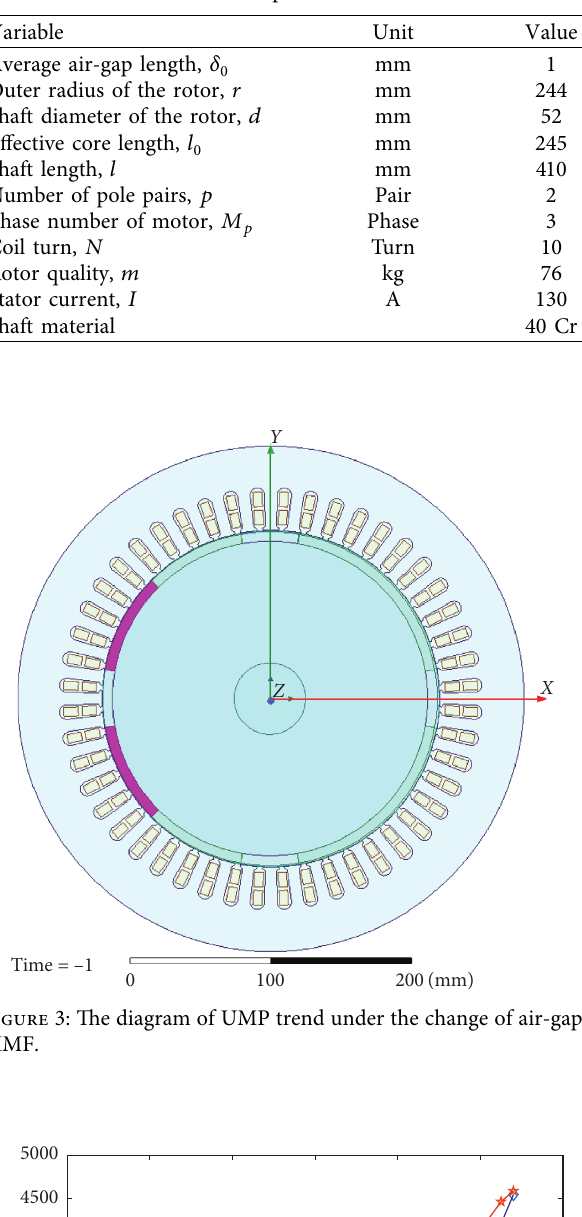
Table 1: The main parameters of PMSM.